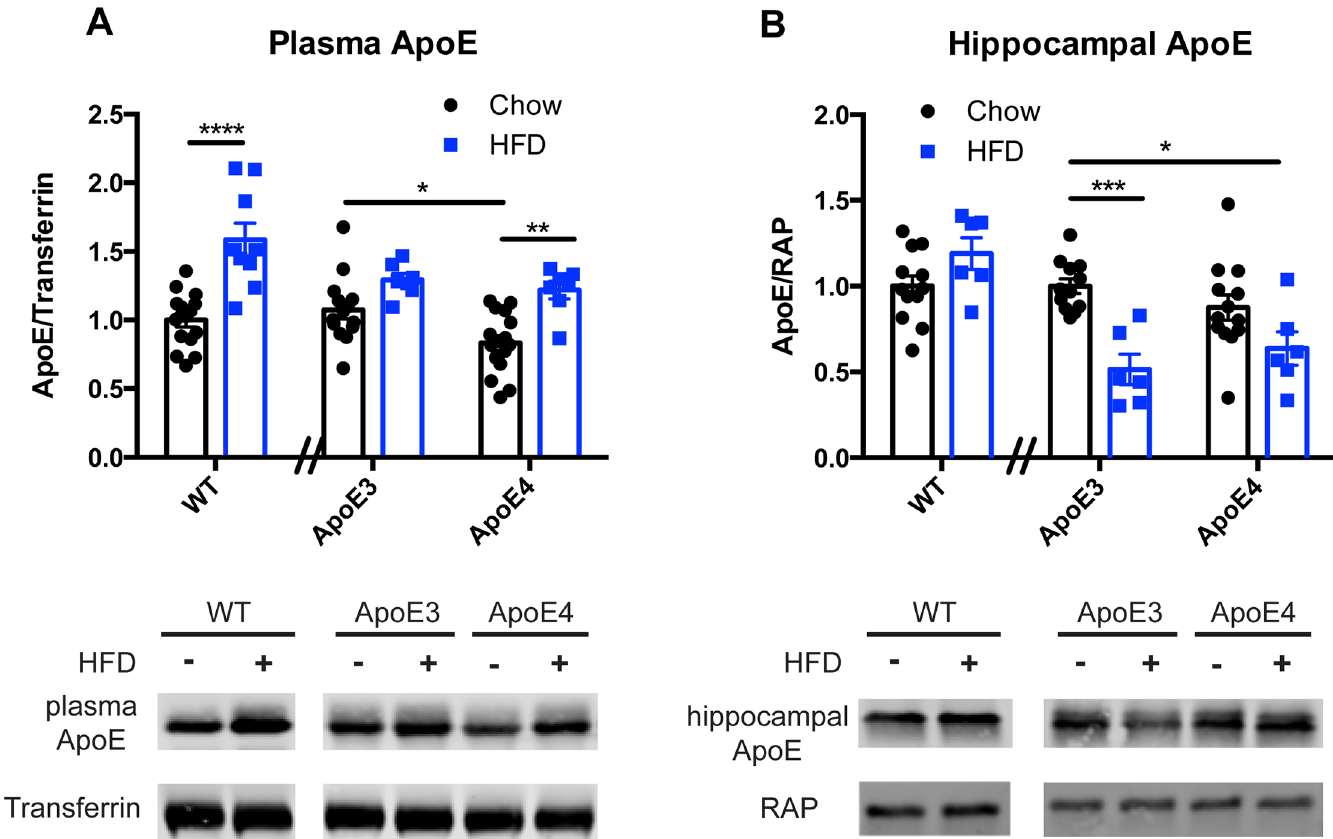
Fig 1. Effect of high-fat diet on plasma and hippocampal ApoE. A.) Plasma ApoE levels after 5 weeks on a high-fat or chow diet in wildtype, ApoE3 TR, and ApoE4 TR mice. WT:chow (n = 15), WT:HFD (n = 9), ApoE3:chow (n = 14), ApoE3:HFD (n = 7), ApoE4:chow (n = 16), ApoE4:HFD (n = 7). B.) Hippocampal ApoE levels after 5 weeks on a high-fat or chow diet in wildtype, ApoE3 TR, and ApoE4 TR mice. For all genotypes on HFD, n = 6. WT:chow (n = 12), ApoE3:chow (n = 12), ApoE4:chow (n = 13). Data are shown as mean ± S.E.M. ( * = p < 0.05, ** = p < 0.01, *** = p < 0.001, **** = p <